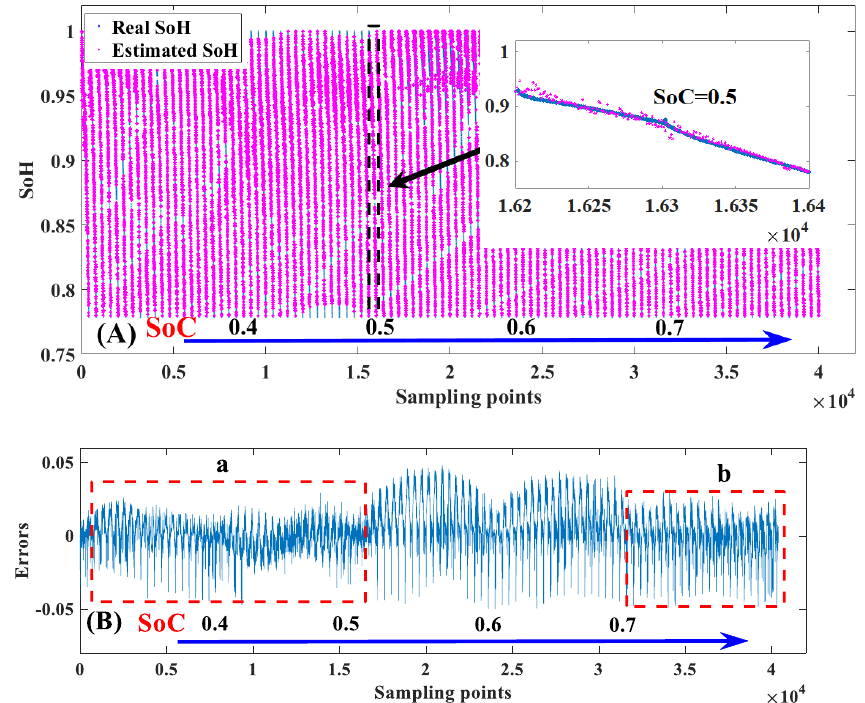
Figure 8. Estimation results of SoH: ( A ) Estimation results of SoH on SoC from 0.3 to 0.8; ( B ) errors of SoH on SoC from 0.3 to 0.8.